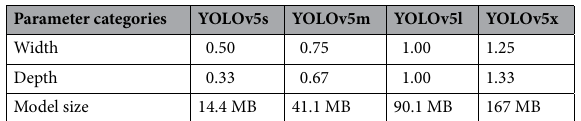
Table 1. Summary of the network model parameters for the YOLOv5